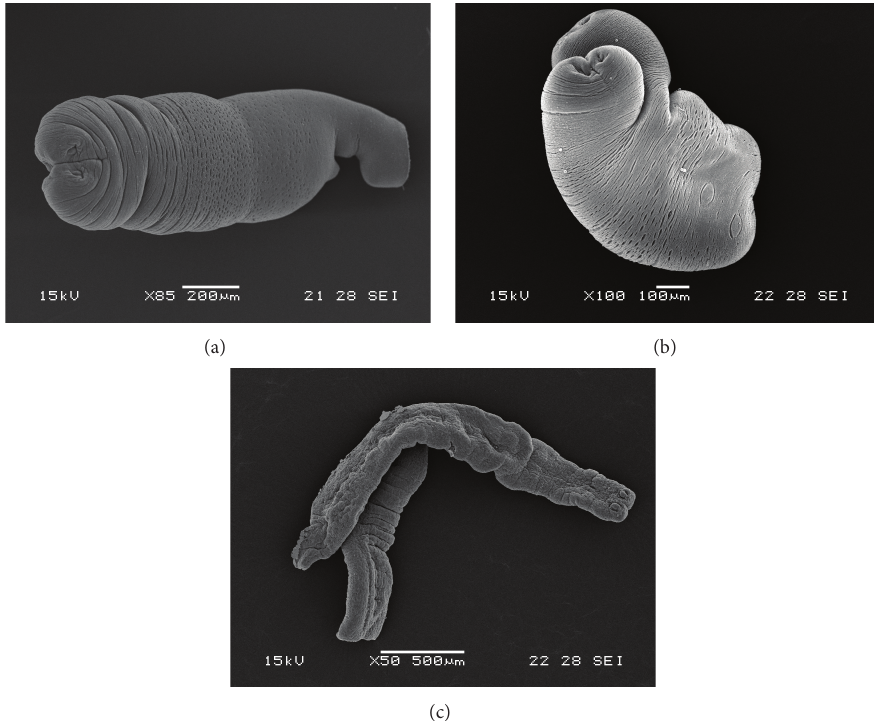
Figure 2: Determination of infectivity to mice. (a) Control tetrathyridium before being injected into mouse (85x). (b) Control tetrathyridium extracted from a mouse after 2 months following infection (100x). (c) Tetrathyridium exposed to thymol (250 𝜇 L/mL, overnight) before being injected into mouse. Note the loss of morphology and microtriches. The body appeared elongated and flattened (50x).